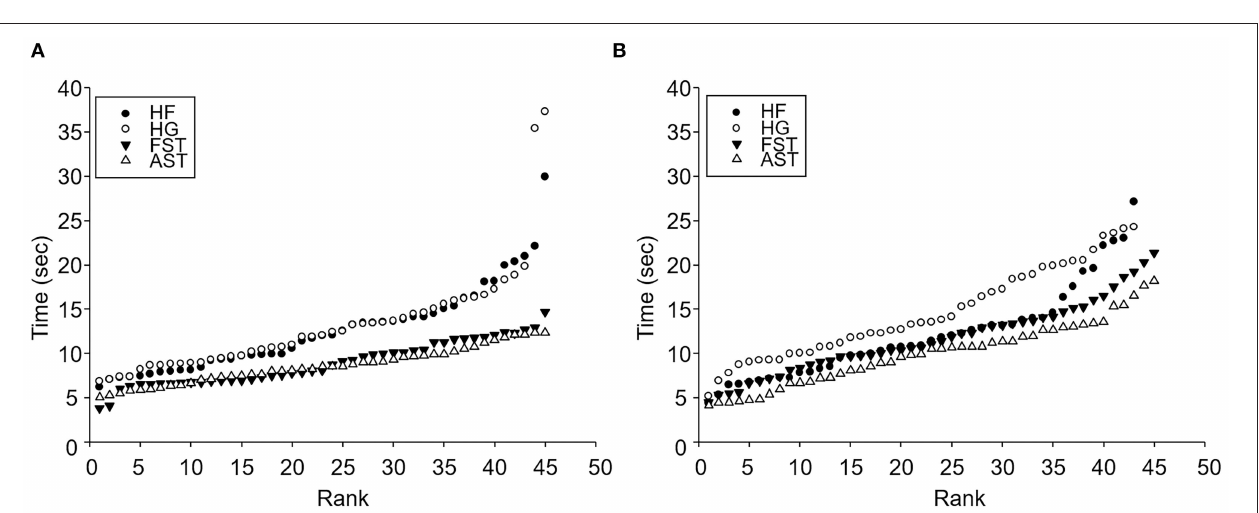
(FST: R 2 = 0.957, F = 952.564, p < 0.001; AST: R 2 = 0.968, F